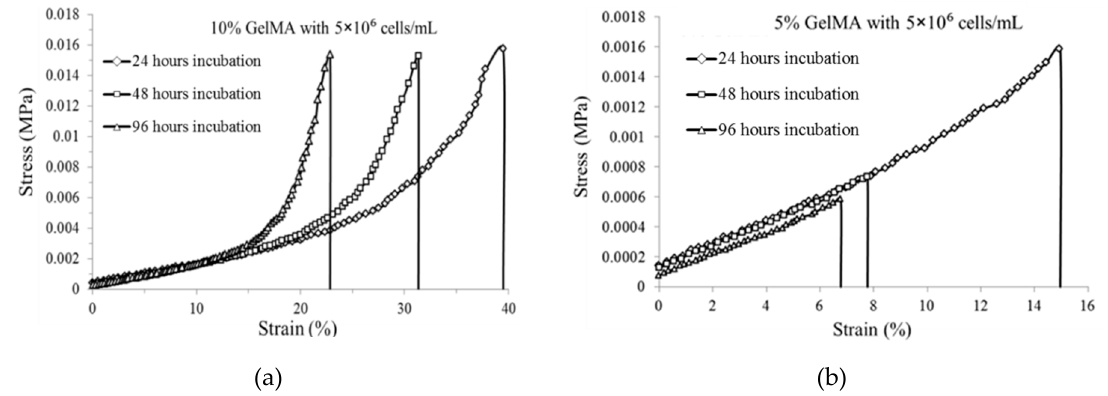
Figure 4. Stress–strain curves of GelMA (5 × 106 cells/mL) for ( a ) 10% GelMA and ( b ) 5% GelMA after 24 h, 48 h, and 96 h of incubation (a diamond represents 24 h of incubation, a square represents 48 h of incubation, and a triangle represents 96 h of incubation).